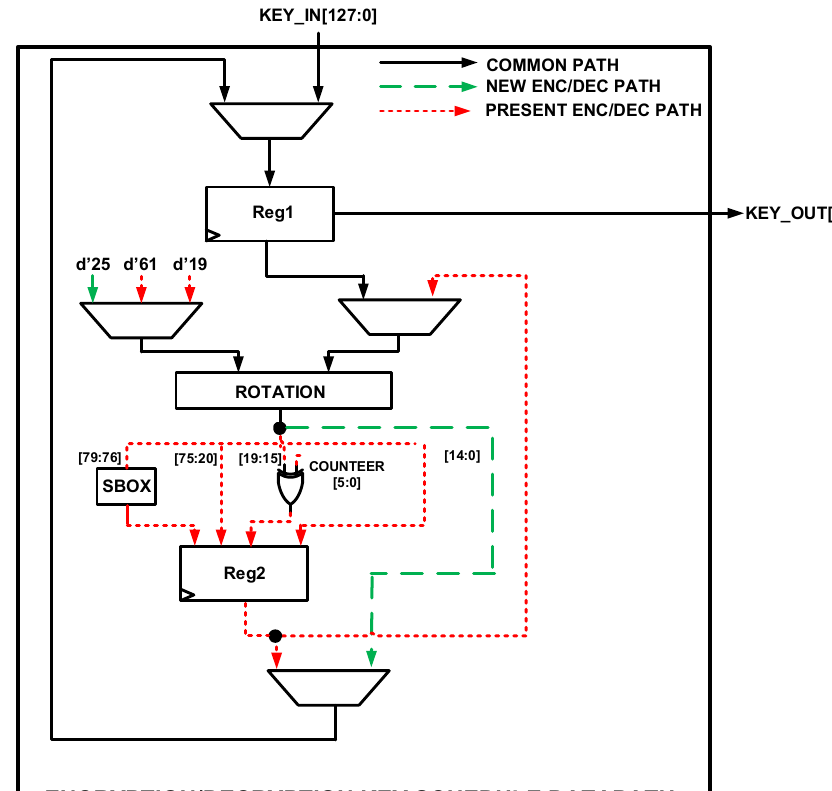
Figure 16. Proposed hardware architecture for unified key schedule.